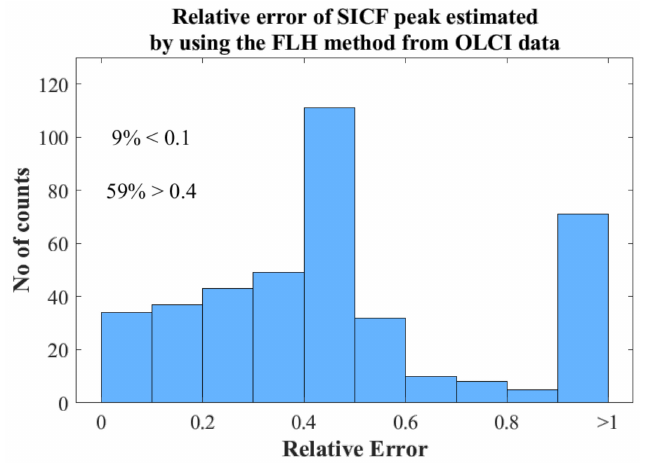
Figure 12. Histogram of the relative errors between the “reference” SICF peak and the estimated SICF peak by using FLH method over convolved data to OLCI ISRF. The X -axis is the relative error, and the Y -axis is the number of